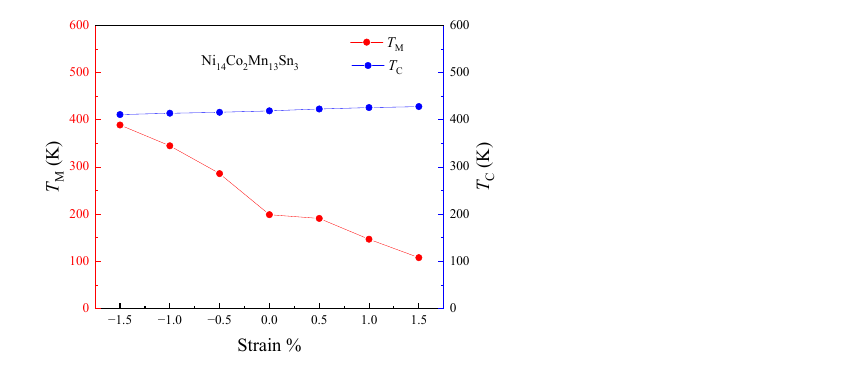
Figure 5. Relationship of ΔΕ A-M and experimental T M of alloys.